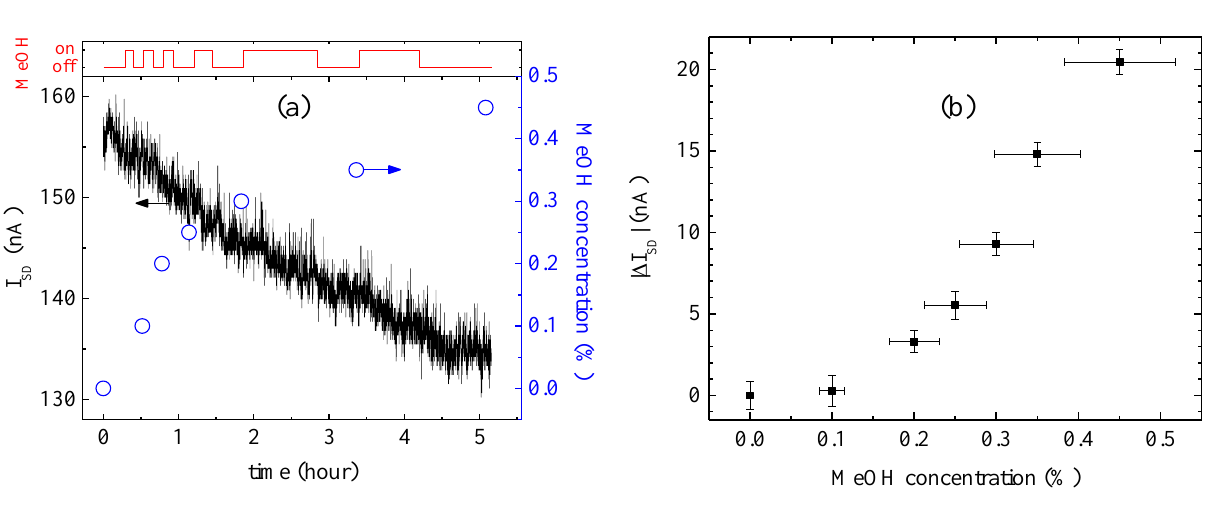
Figure 6. Methanol vapor detection in the glove box; ( a ) the SAPC current value of the CNT sensor and the methanol vapor concentration according to the control of the methanol vapor flow and ( b ) electrical current variation against the methanol vapor concentration.